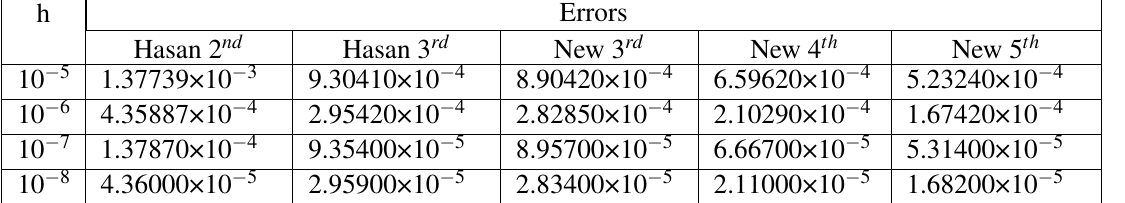
Table 4.2 (a): Absolute errors of the solution of Eq. (22) at x=0.0001 by Hasan’s [13, 16] methods and new methods.